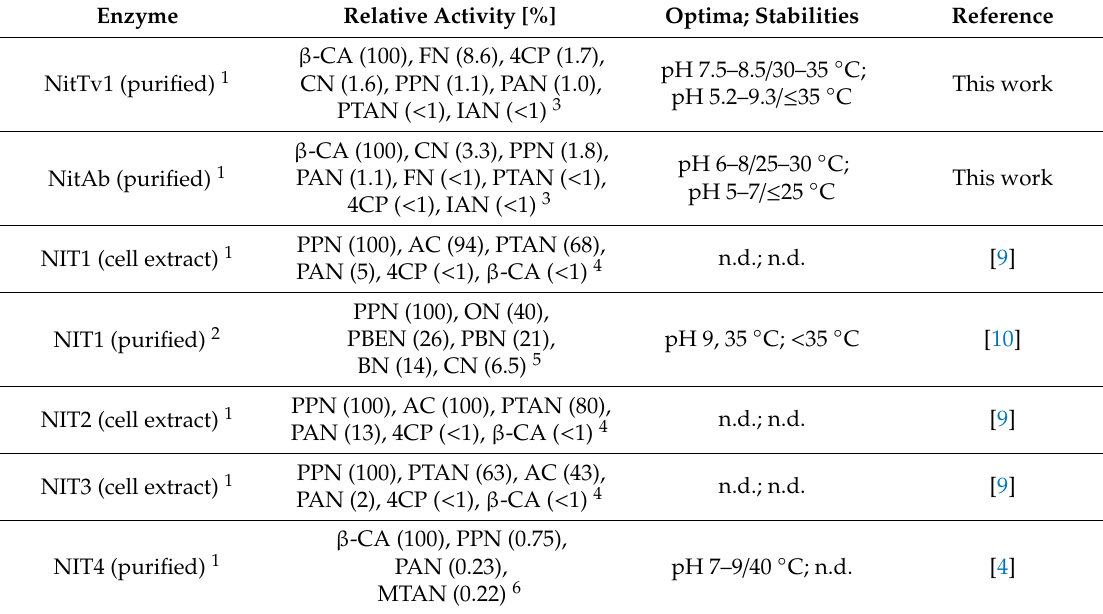
Table 3. Comparison of biochemical properties of fungal nitrilases NitTv1 and NitAb and plant nitrilases from Arabidopsis thaliana (NIT1–NIT4). Enzyme Relative Activity [%] Optima;